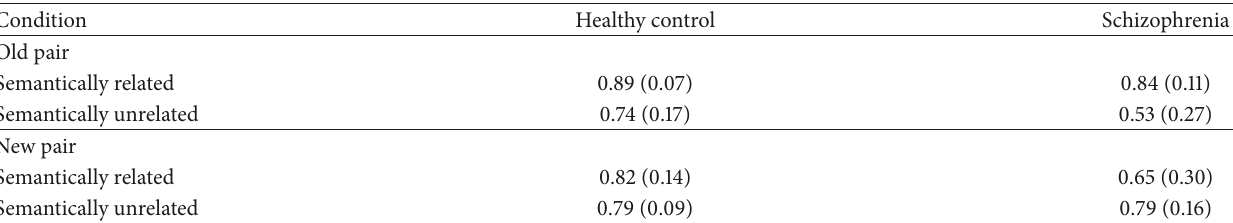
Table 2: Mean correct response rates and standard deviations for each word pair and coherence condition in healthy controls and schizophrenia